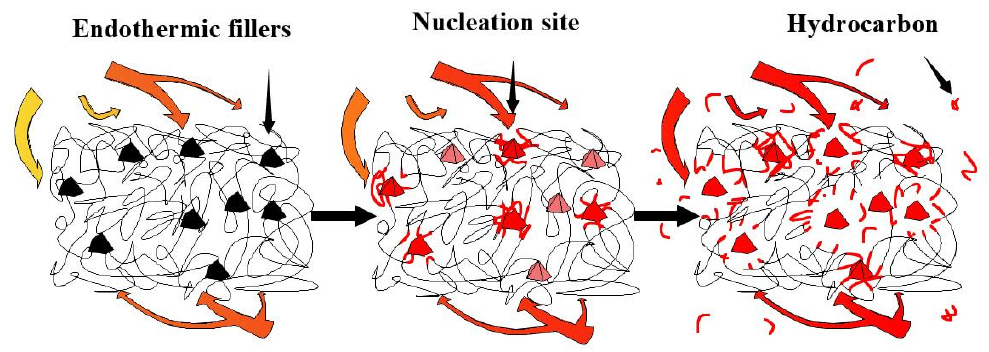
Figure 8. Schematic diagram of the pyrolysis of Reaction I.